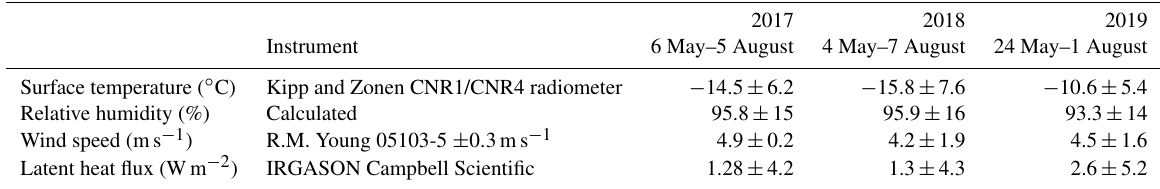
Figure 1. (a) A map of Greenland with a green dot indicating the EastGRIP site (Wahl et al., 2021). (b) A photograph of the clean snow area at the field site (Credit: Bruce Vaughn), black lines indicate the SSA sampling transect with 10m spacing shown as dashed lines. (c) A photograph of SSA sampling cups (Credit: Sonja Wahl), and (d) an illustration of the sampling device from Klein (2014). Table 1. Weather statistics for summer field campaigns in 2017, 2018 and 2019. Mean and standard deviation for weather variables during the three sampling seasons. Surface temperature, relative humidity with reference to ice and wind speed use PROMICE weather station based on 10min measurements. Latent heat flux, a 30min mean upwards flux from the eddy covariance